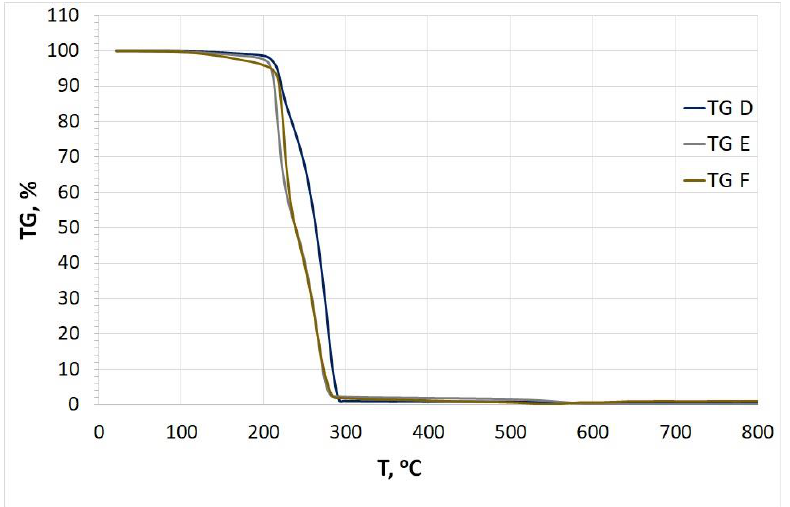
Figure 7. TG results of explosives containing microstructure charcoal grains of −90 μm , sample 2 (TG A), sample 3 (TG B), sample 4 (TG C).